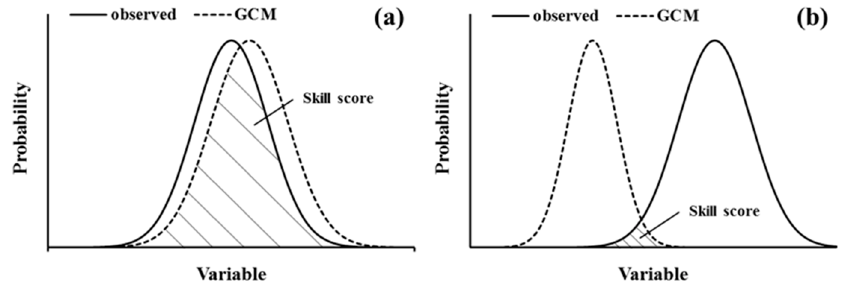
Figure 3. Diagrams of the general circulation model (GCM) vs the observed probability density function (PDF), illustrating the total skill score in ( a ) a near-perfect skill score and ( b ) a very poor skill score.